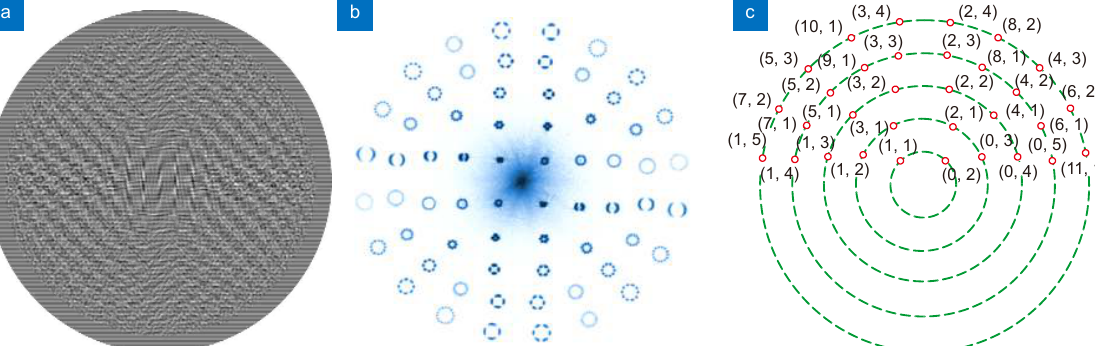
Fig. 20 | Binary 14-channel DOE for investigating the polarization and phase positions of vortex cylindrically polarized beams . ( a ) DOE phase. ( b ) Correspondence of the diffraction orders in the focal plane to the orders of optical vortices 198 . a b